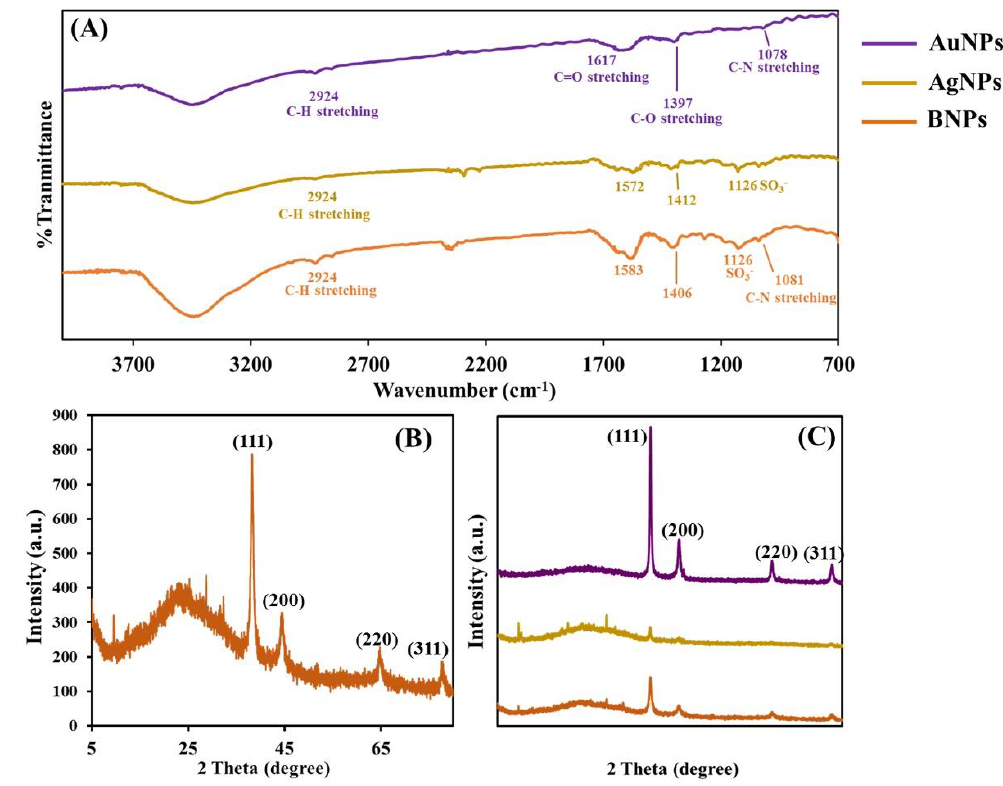
Figure 4. ( A ) the FT–IR spectra of the Au–Ag BNPs compared with the PDADMAC–AuNPs